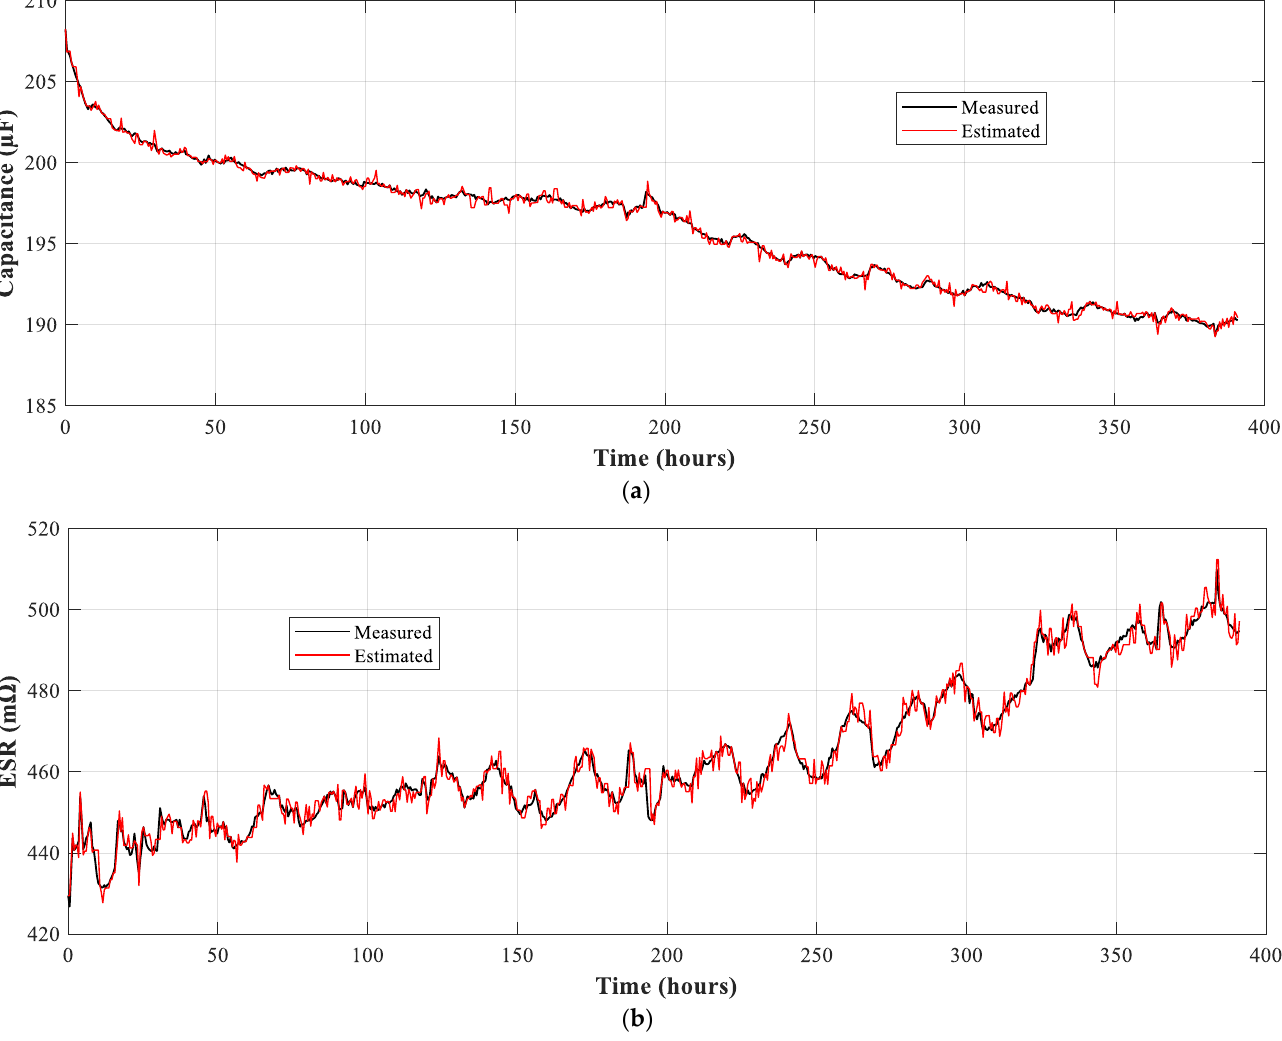
Figure 11. Measured and estimated values during the accelerated aging test. ( a ) Capacitance; ( b ) ESR.